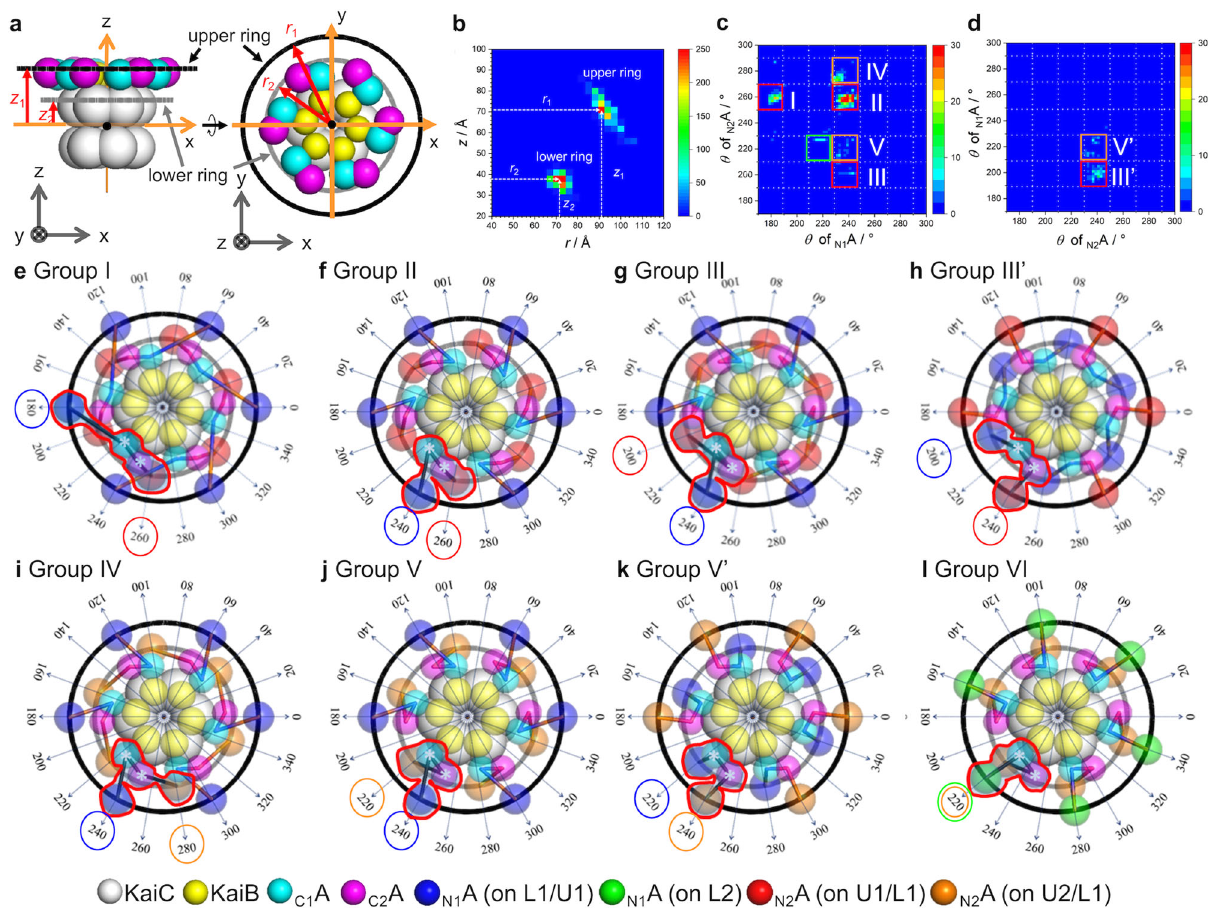
Fig. 3 Classi fi cations of structural models based on the location of N A domains. a Location of two rings on which N A domains distribute. Black and gray show upper and lower rings, respectively. The components are expressed with color spheres (see the indexes in the bottom). b Distribution of N A domains as a function of r and z directions. c Cell-correlation distribution map for the N1 A and N2 A domains, which locate on the upper and lower rings, respectively. Red, orange, and green squares show cell-combinations of U1-L1, U1-L2, and U2-L2 set, respectively (about the ‘ cell ’ , see Supplementary Fig. 6a). Capital roman numerals, I – VI, indicate structural groups considering N A and C A domain connection. d Cell-correlation distribution map for the N1 A and N2 A domains, which locate on the lower and upper rings, respectively. Red and orange squares show cell-combinations of U1-L1 and U1-L2 set, respectively (about the ‘ cell ’ , see Supplementary Fig. 6a). In Groups III ’ and V ’ , the locational combination for the N1 A and N2 A domains are opposite to the cases of Groups III and V, respectively. e – l Top views of the eight structural groups. Radial arrows show azimuth angles on x-y plane. One A 2 dimer including C1 A ( θ = 230°) and C2 A ( θ = 250°) domains (white asterisks) are surrounded by red lines. Blue and green circles indicate the cell positions of N1 A domains, and red and orange circle also denote the cell positions of N2 A domains. The components are also expressed with color spheres (see the indexes in